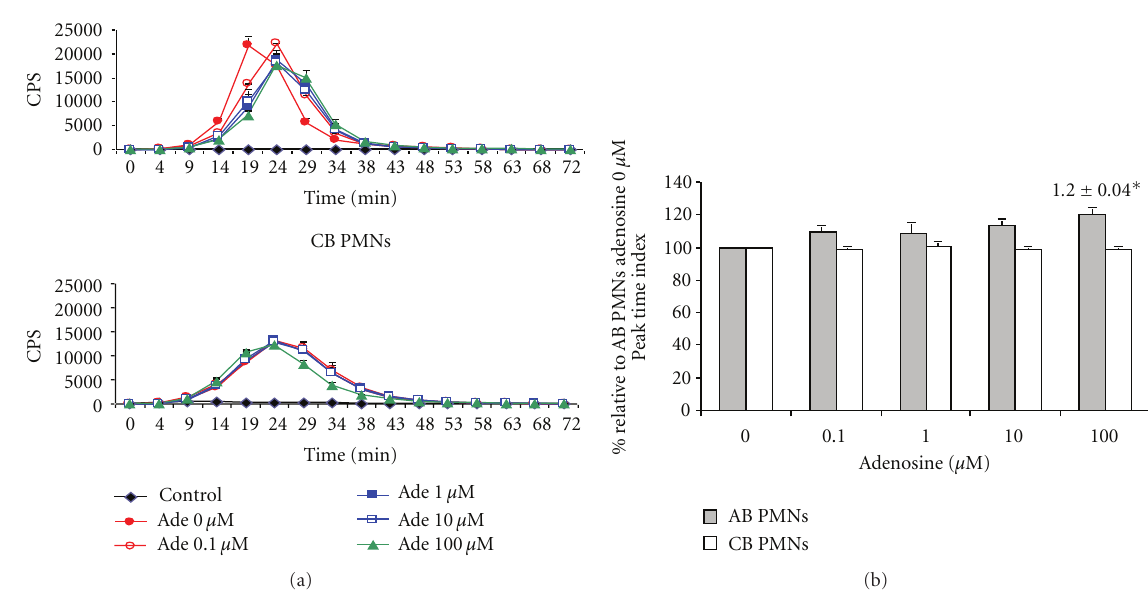
Figure 4: The modulating e ff ects of adenosine on oxygen radical release of neonatal and adult PMNs. (a) The amount of oxygen free radicals released by PMNs was determined by chemiluminescence. Cord blood PMNs had lower PMA-induced oxygen free radical production than adult PMNs. The results are representative of 6 duplicate experiments. (b) Plots illustrate the relative peak time of oxygen radicals released by adult and cord blood PMNs. The results were normalized to those obtained in pair-controlled studies of adult PMNs with adenosine 0 μ M. Data are expressed as mean ± SD. ∗ P < 0 . 05 as compared with adenosine 0 μ M. Data presented are calculated from 6 duplicate